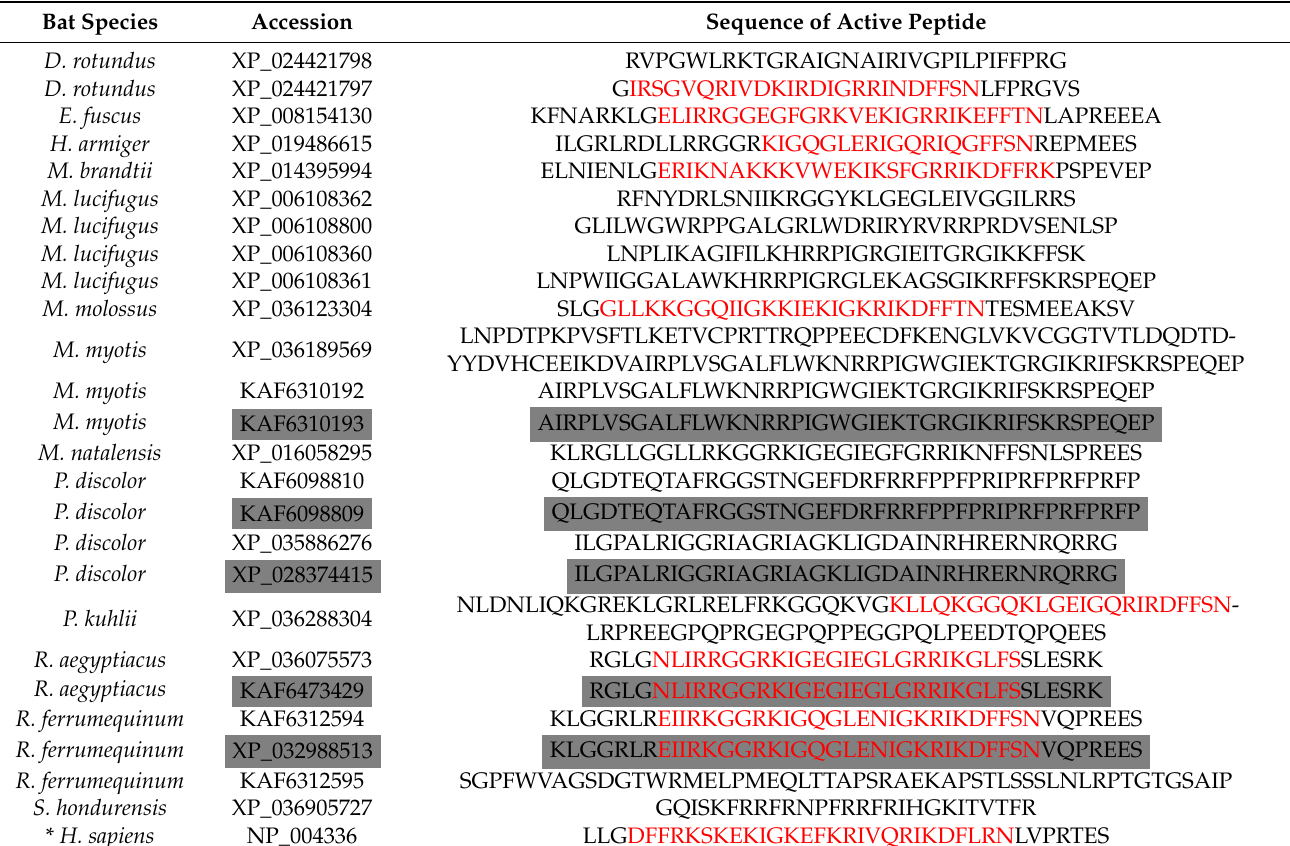
Table 3. Predicted cathelicidin active peptides of the bat sequences corresponding to the C-terminal portion of the protein after removal of the cathelin-like